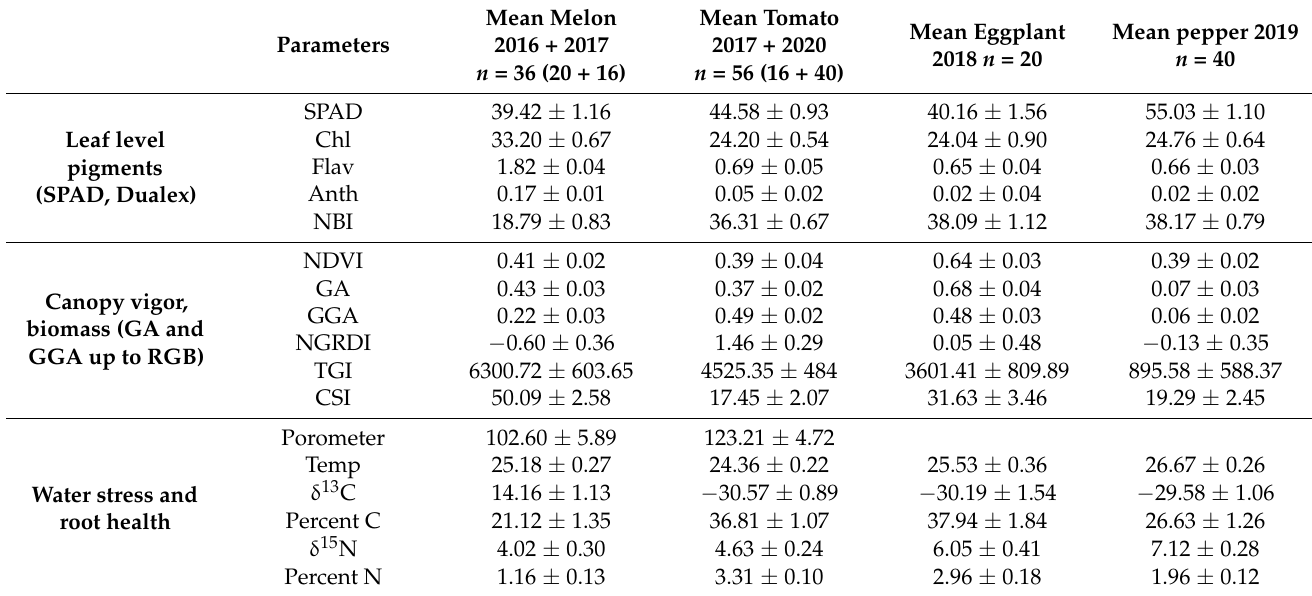
Table 3. Mean and standard error of each crop combining values of repeated years of crops for three classes of parameters (leaf level pigments, canopy vigor and biomass, water stress and root health), n =